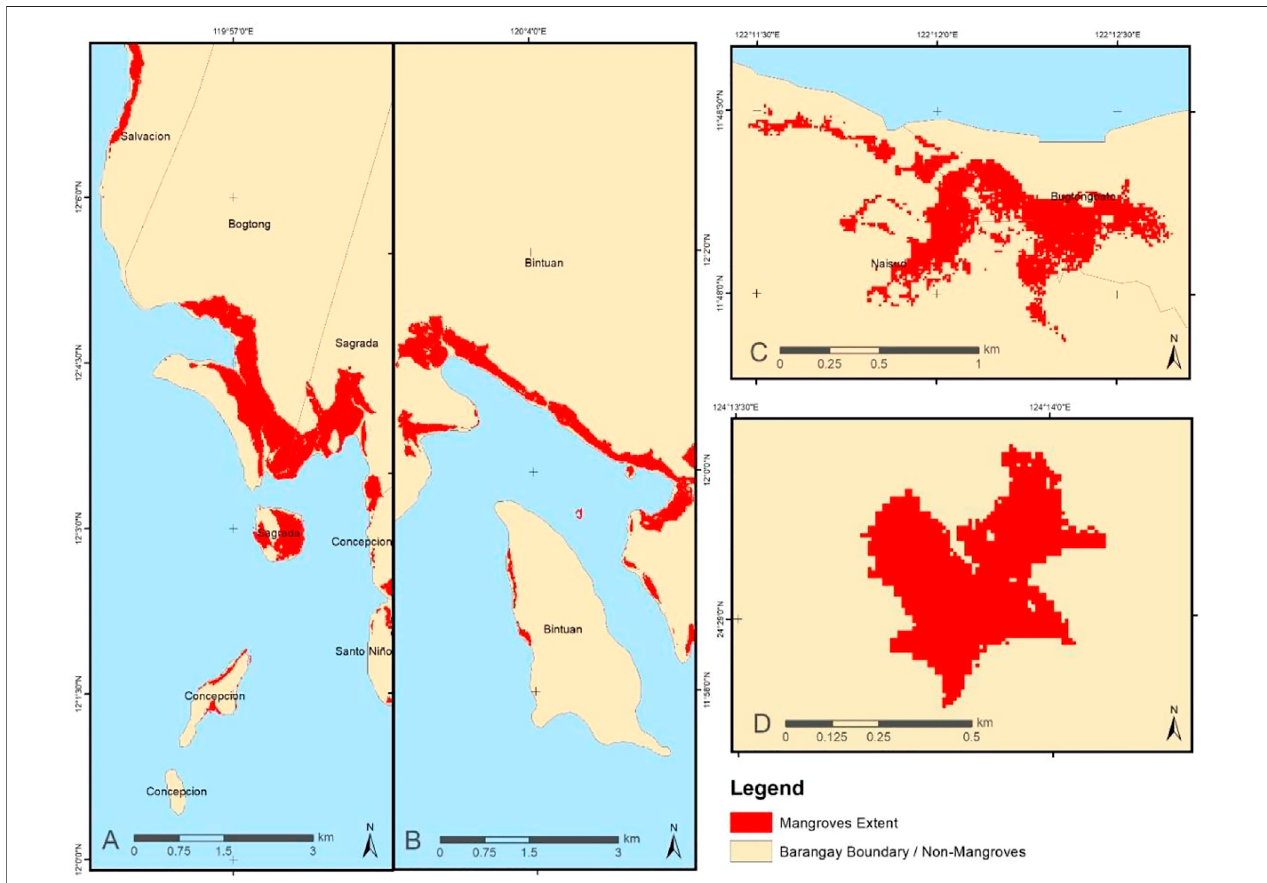
FIGURE3| Mangroveextentmapsfor (A) Busuanga, (B) Coron, (C) KIIEcoparkand (D) FukidoParkgeneratedusingtheMLCsupervisedclassi fi cationtechnique implemented in ENVI software.